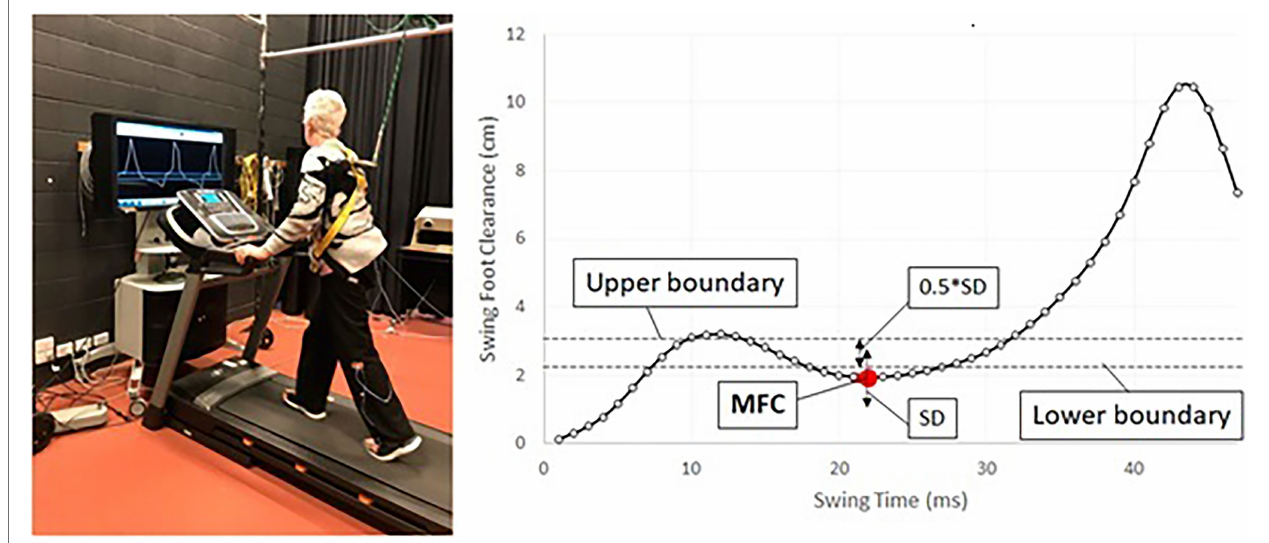
FIGURE 4 | Protocol for biofeedback training for MFC. (left) Biofeedback training setup, (right) concept of MFC biofeedback training, red dot (MFC), targeting to control MFC within the band between upper/lower boundaries, target band = (mean + SD) ±